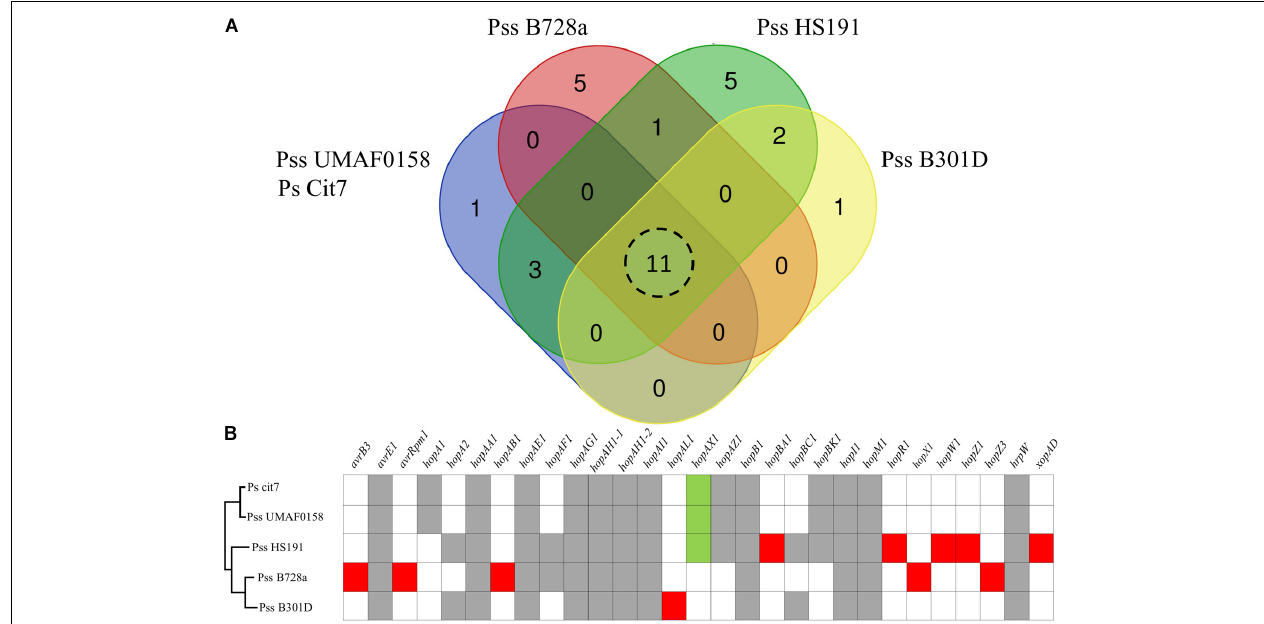
FIGURE 5 | Type III effectors repertoire. (A) Venn diagram comparing the putative type III effectors presence in selected strains of P. syringae including the model strain P. syringae pv. syringae isolated from mango UMAF0158. Eleven type III effectors shared by all the strains analyzed. (B) Presence of specific type III effectors. Gray boxes indicate type III effectors presence in all the strains analyzed. Red boxes indicate type III effectors specific for each strain analyzed. Green boxes represents the hop AX1 effector, an effector present in UMAF0158 that shows a high-specificity for a few strains of different pathovars exclusively belonging to the Genomospecies 1-Phylogenetic Group